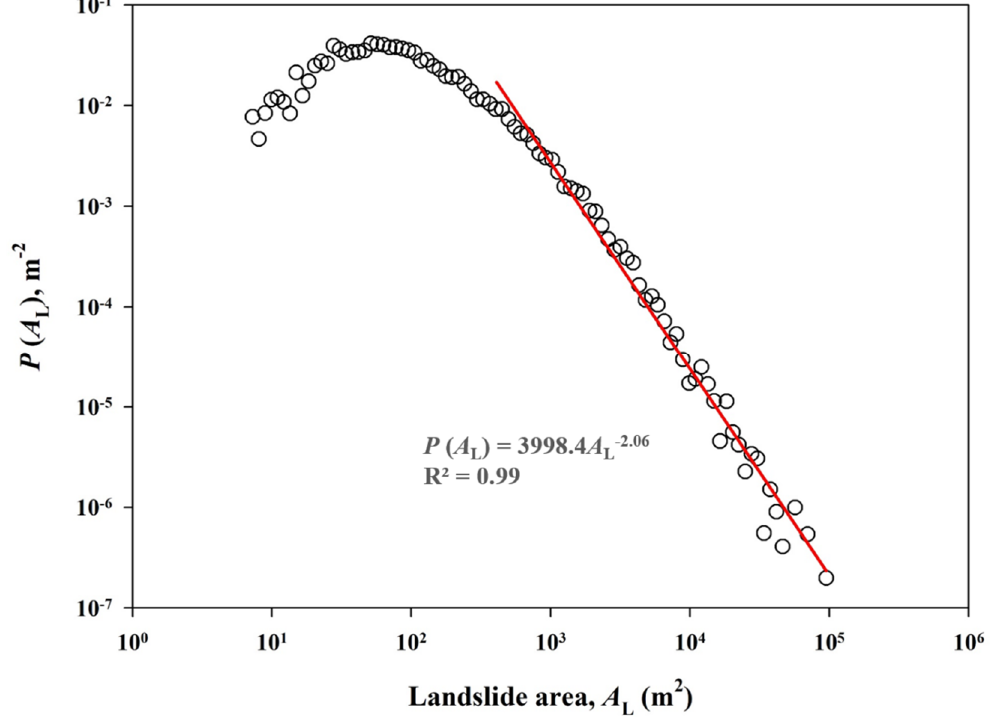
Figure 4. Probability of density distribution for landslide area.